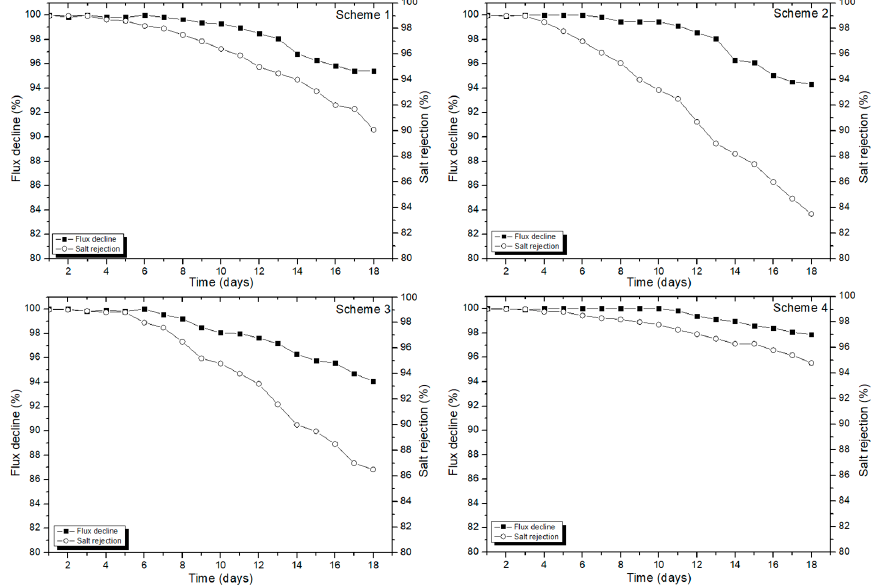
Figure 2. The permeate flux and salt rejection in RO operation for Schemes 1, 2, 3, and 4, operated with CA-1, CA-2, CA-3, and CO 2 as antiscalants, respectively.